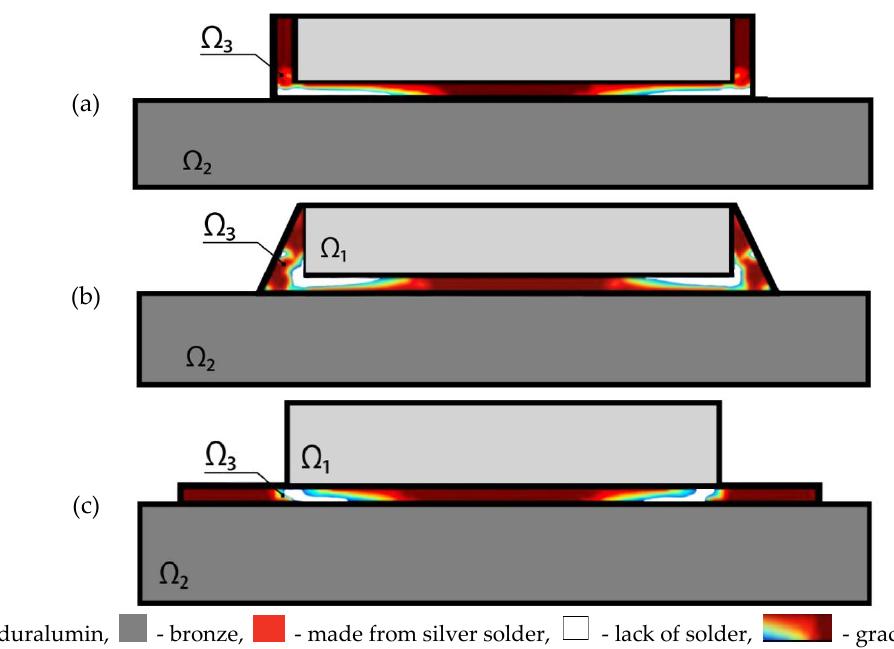
Figure 8. Topology of the solder structure. ( a ) the solder is located around the structure; ( b ) the solder is arranged in a pyramid shape; ( c ) the solder is located under the structure. Table 3. Optimal graded microstructures of the solder